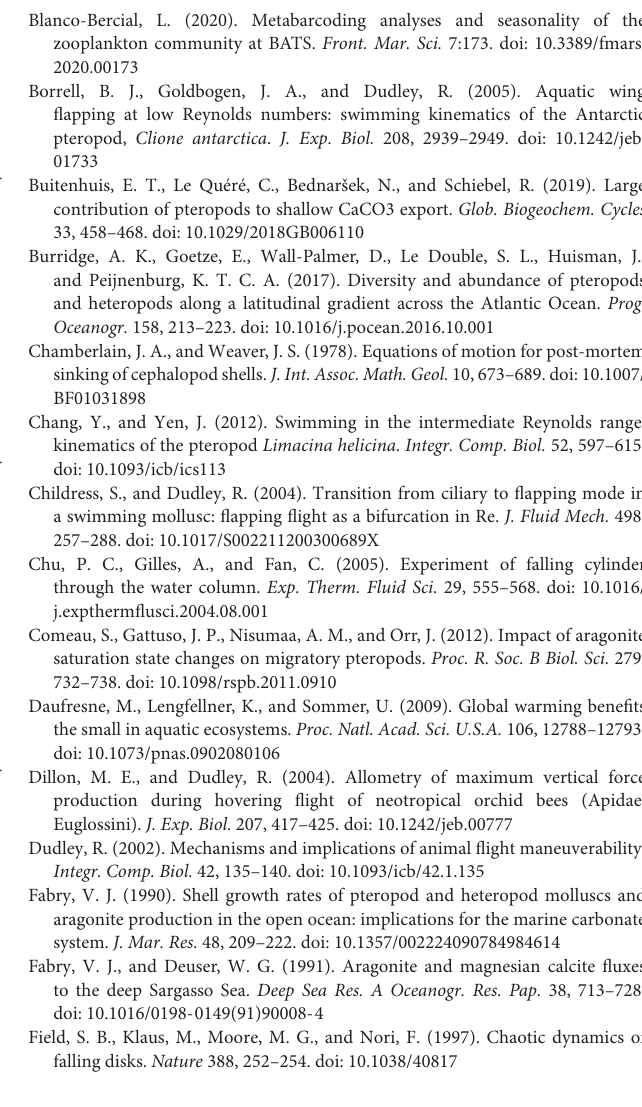
FIGURE S1 | Box plots of mean swimming speed, normalized mean swimming speed, sinking speed, and normalized mean sinking speed for three different shell shape groups. (A) Mean swimming speed. (B) Normalized mean swimming speed. (C) Mean sinking speed. (D) Normalized mean swimming speed plot. Groups which do not share a letter are statistically different from each other ( p < 0.05) as determined by a one way ANOVA test and Tukey-Kramer pairwise comparisons. Outliers are demarcated as a plus sign ( + ). FIGURE S2 | Swimming speed U of individual marine snails as a function of wing flapping frequency f for various marine snail species.